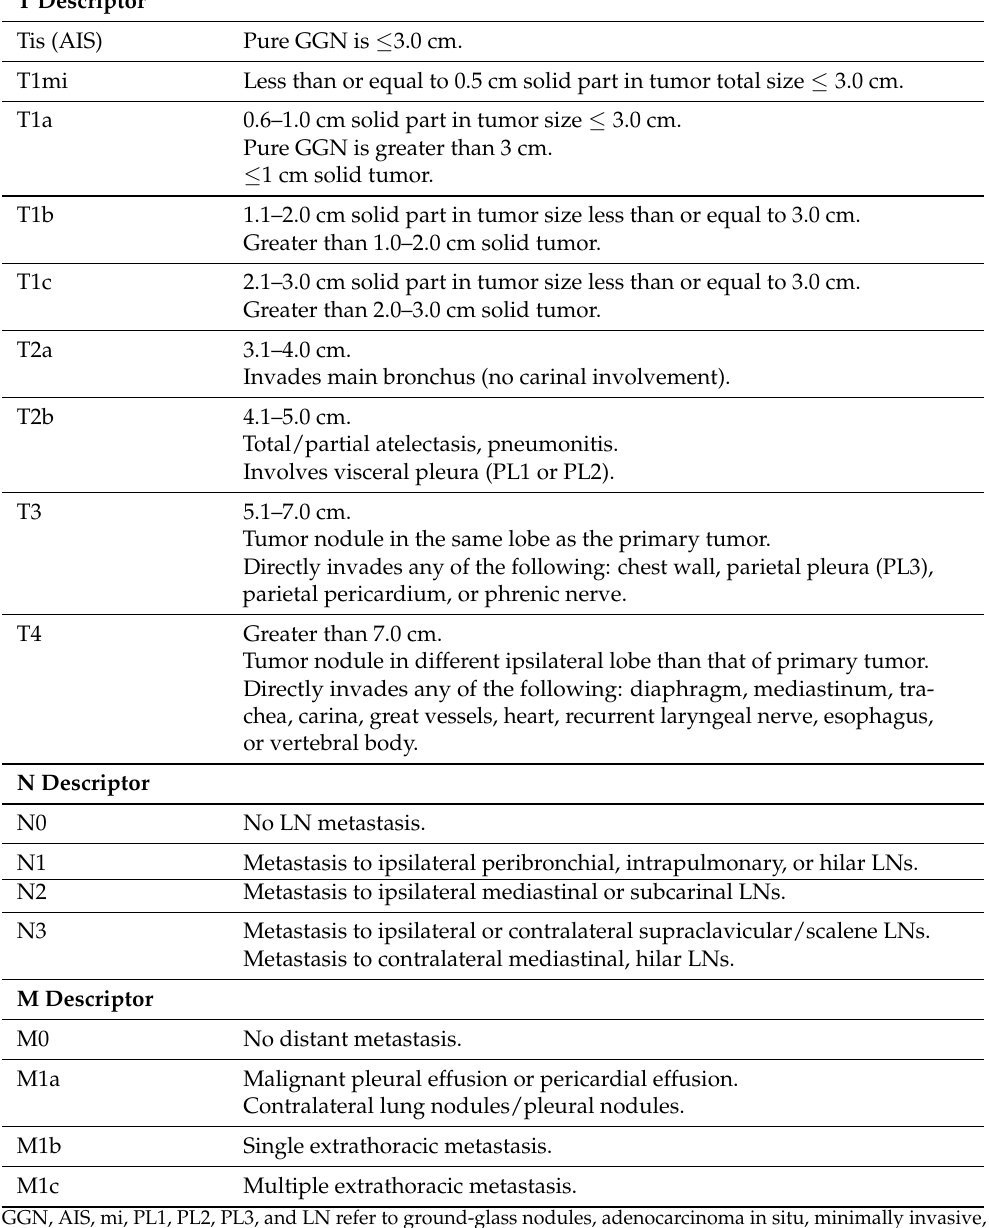
Table 1. Imaging appearance for TNM lung cancer staging in the eighth edition